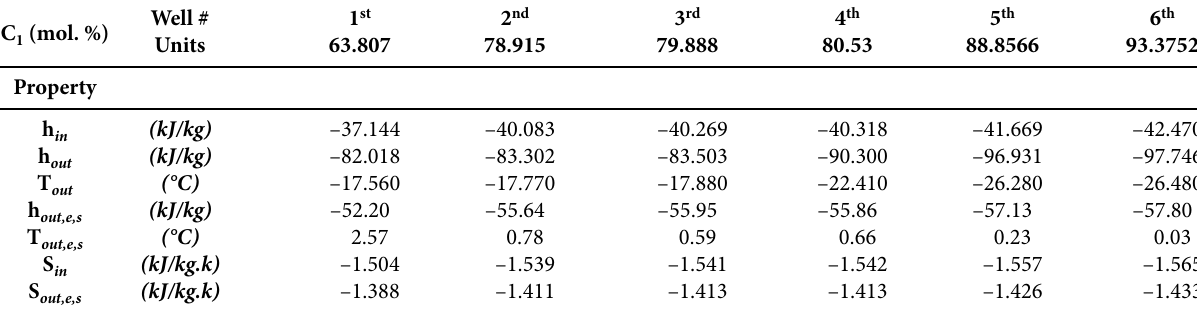
Table 3. Effect of Methane concentration (C1%) variation on all properties C 1 (mol. %)